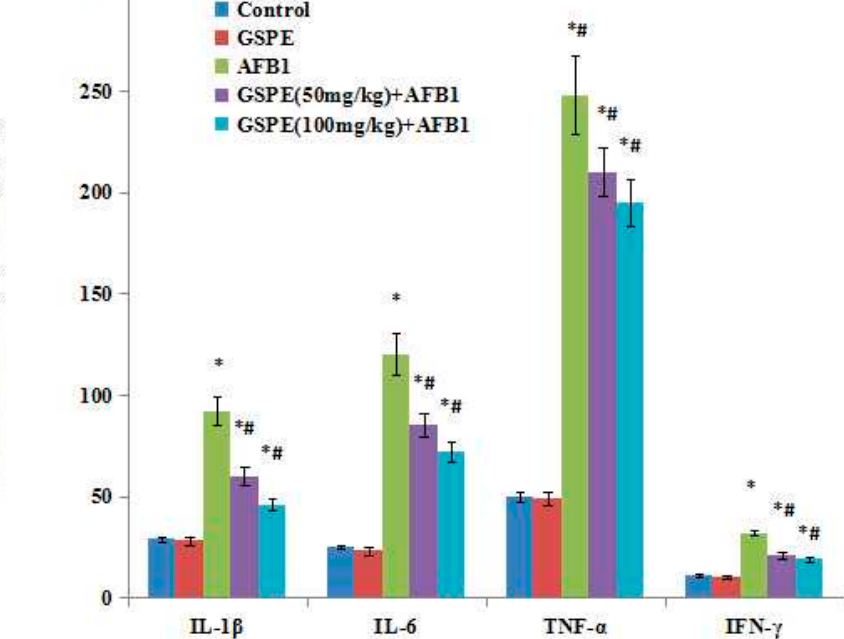
Figure 3. Effect of AFB1, GSPE, and their co-treatment on interleukin 1 β (IL-1 β ), IL-6, tumor necrosis factor α (TNF- α ), and interferon γ (IFN- γ ) in serum of mice. Values are mean ± SEM of ten mice in each group. ǂ p < 0.05 vs. control group, # p < 0.05 vs. AFB1 treated group.